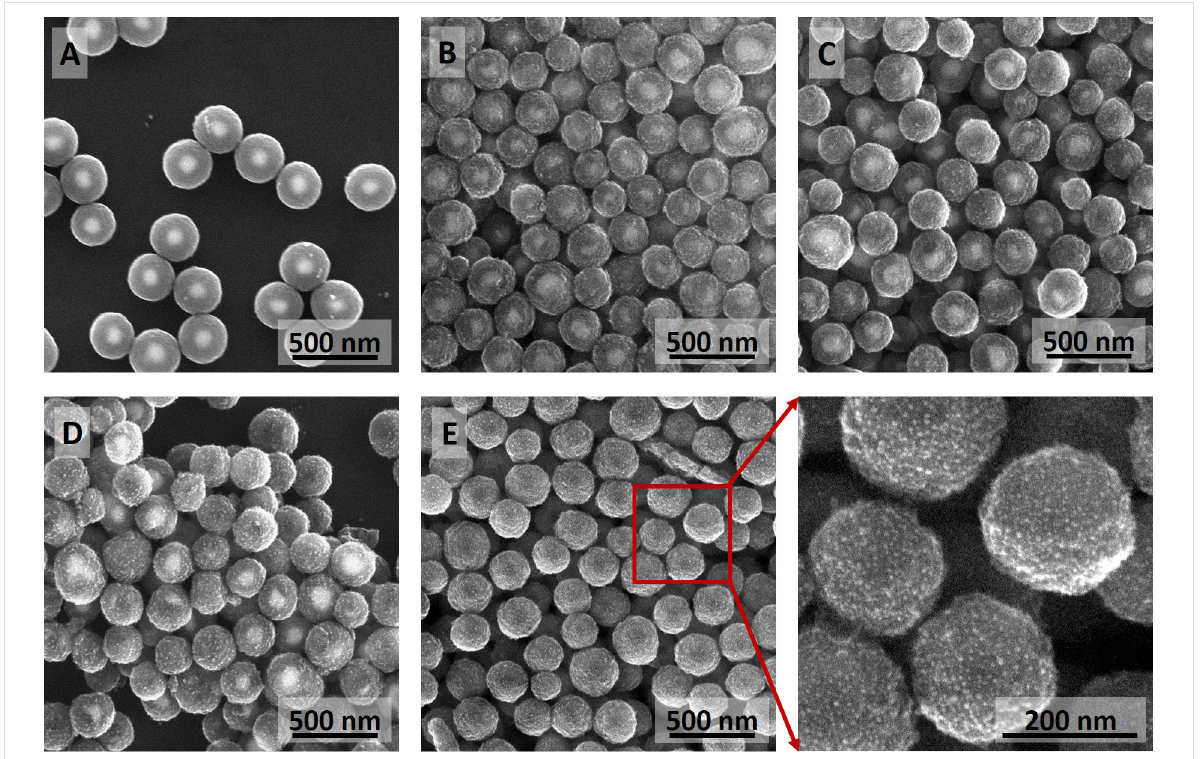
Figure 2: SEM images of freshly prepared Ag–TiO 2 core–shell nanostructures (A) and Ag–TiO 2 core–shell nanostructures after annealing at 150 °C for 0.5 h (B), 1.5 h (C), 3 h (D), and 12 h (E).